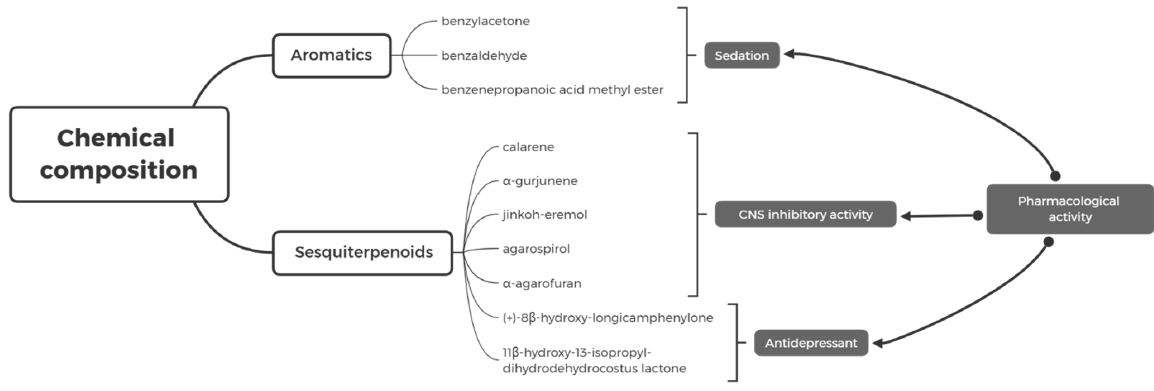
Figure 1. Pharmacological activities of the main monomer components in Agarwood. Table 2. Summary of the sedative and tranquilizing pharmacological activity experiments of agarwood.